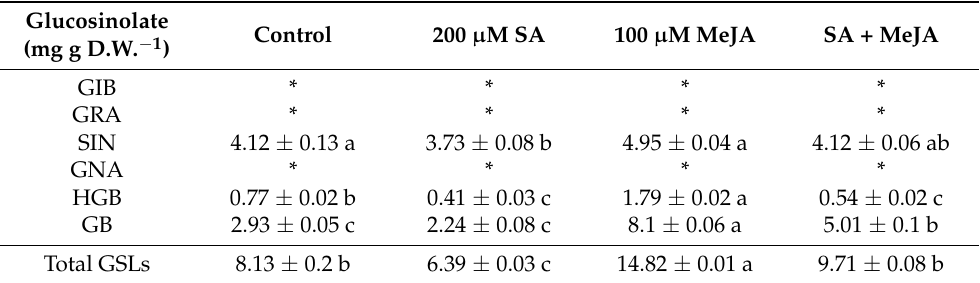
Table 1. Effect of elicitors on glucosinolates of red cabbage inflorescences. The numbers show the average values per treatment ( n = 4) ± standard error. Different letters in a row indicate statistically significant differences in the HSD Tukey’s test ( p <